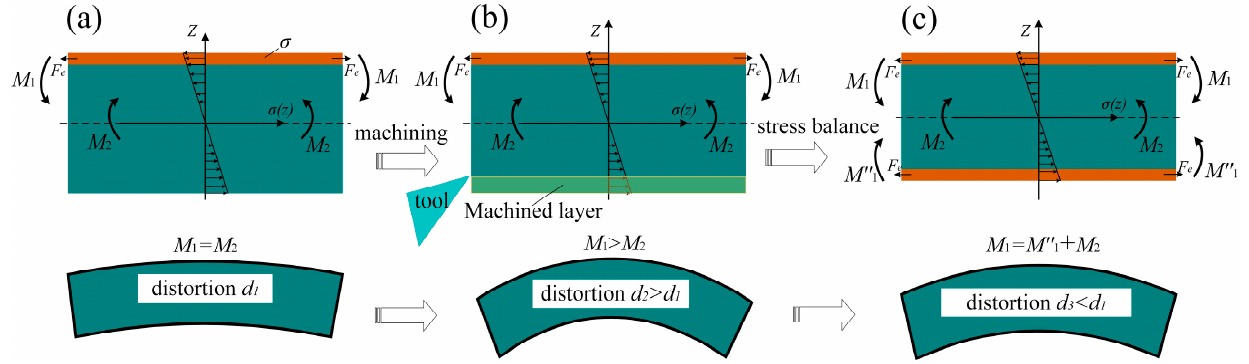
Figure 11. Distortion caused by double-sided machining. ( a ) first machining distortion; ( b ) double- sided machining; ( c ) last machining distortion.